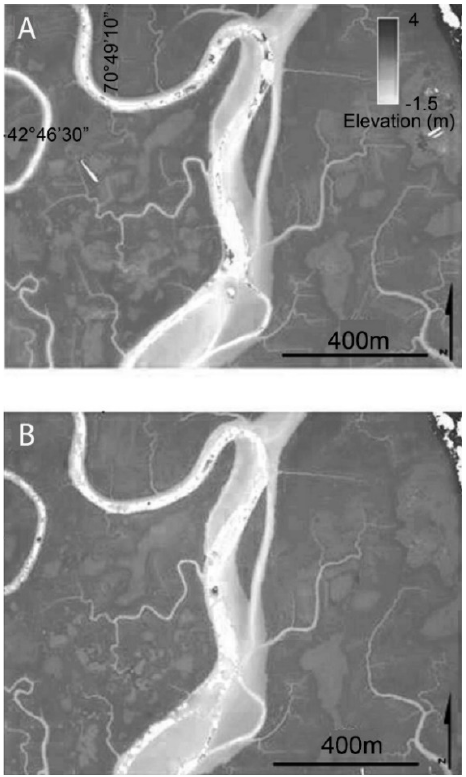
Figure 3. Digital elevation model of marsh surface derived with SfM. ( A ) shows elevation on 14 November 2017. ( B ) shows elevation of the same domain on 27 February 2018.